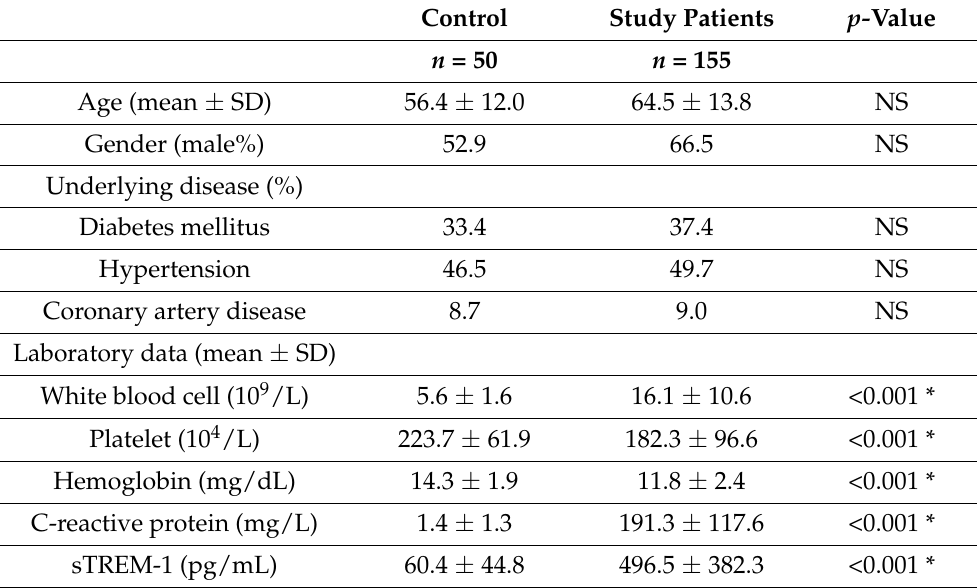
Table 1. Baseline characteristics of patients and control